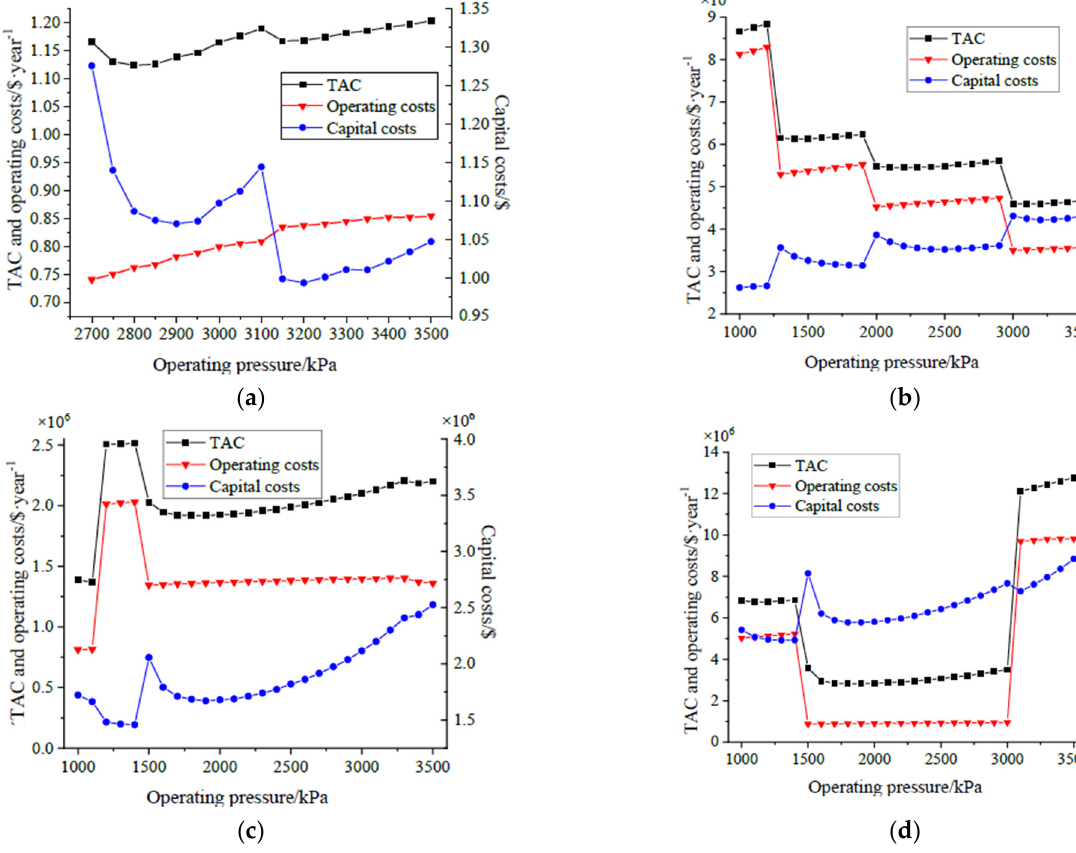
Figure 5. Changes of costs according to the operating pressure: ( a ) demethanizer; ( b ) ethylene column; ( c ) depropanizer; ( d ) propylene